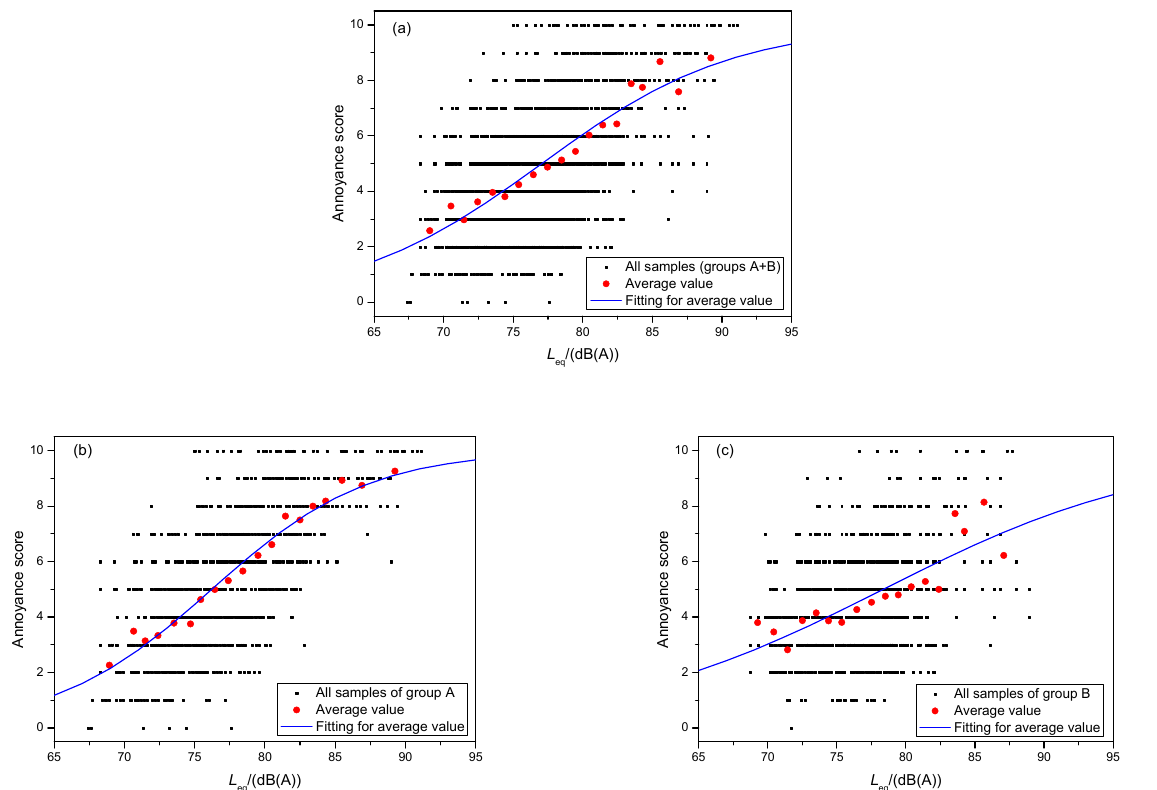
Figure 12. Fitting for the average annoyance score and equivalent SPL values, ( a ) for all samples of groups A and B, ( b ) for samples of group A, and ( c ) for samples of group B.